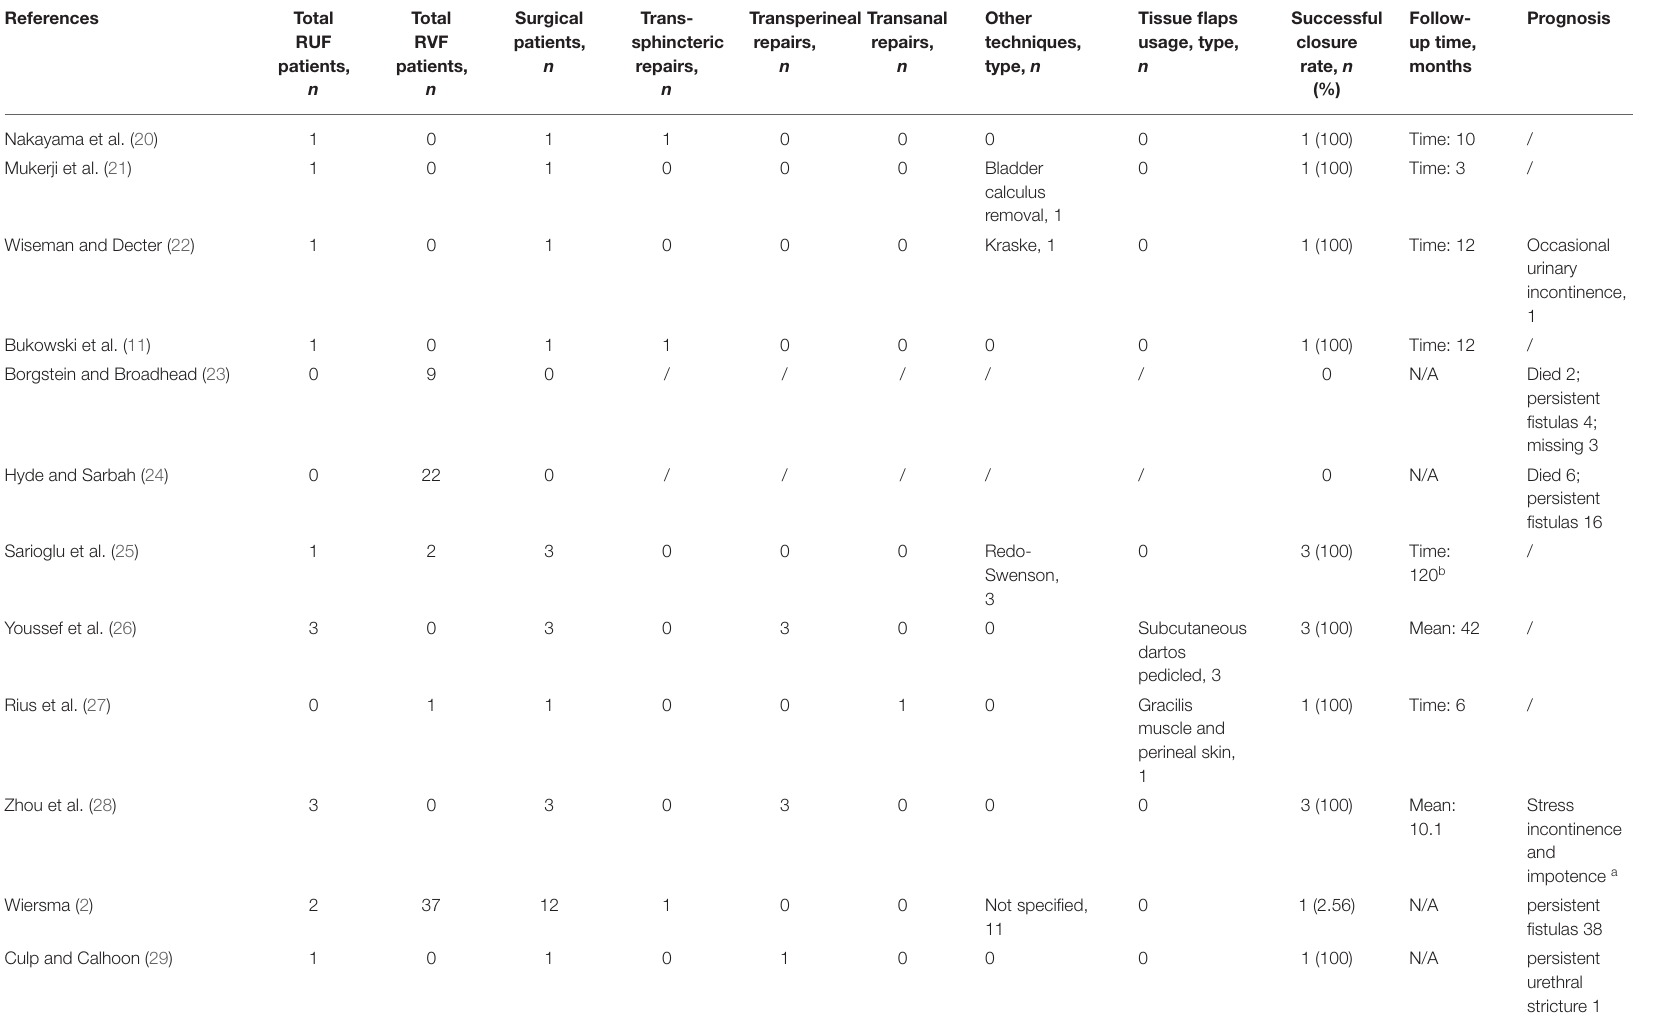
TABLE 2 | Summary statistics for types of surgical repair, tissue flap usage, primary outcomes, follow-up period, and